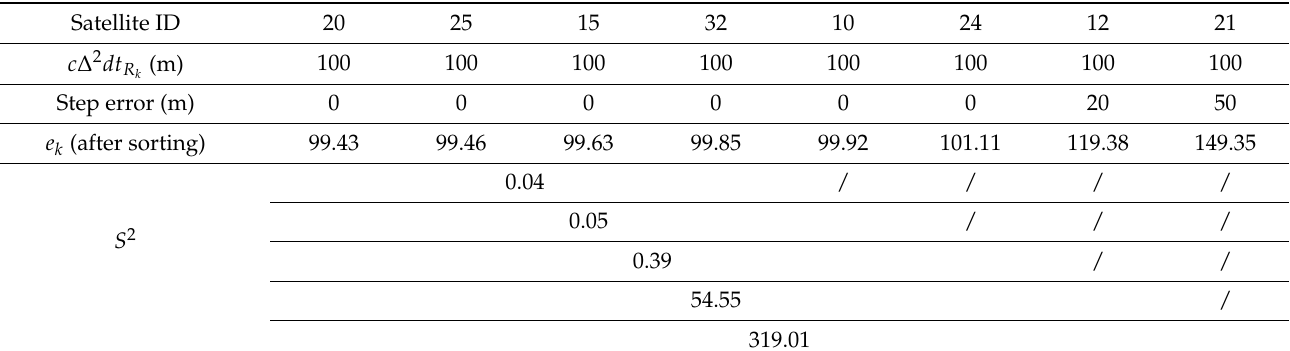
Table 6. An example of windowing results in Scenario 3.